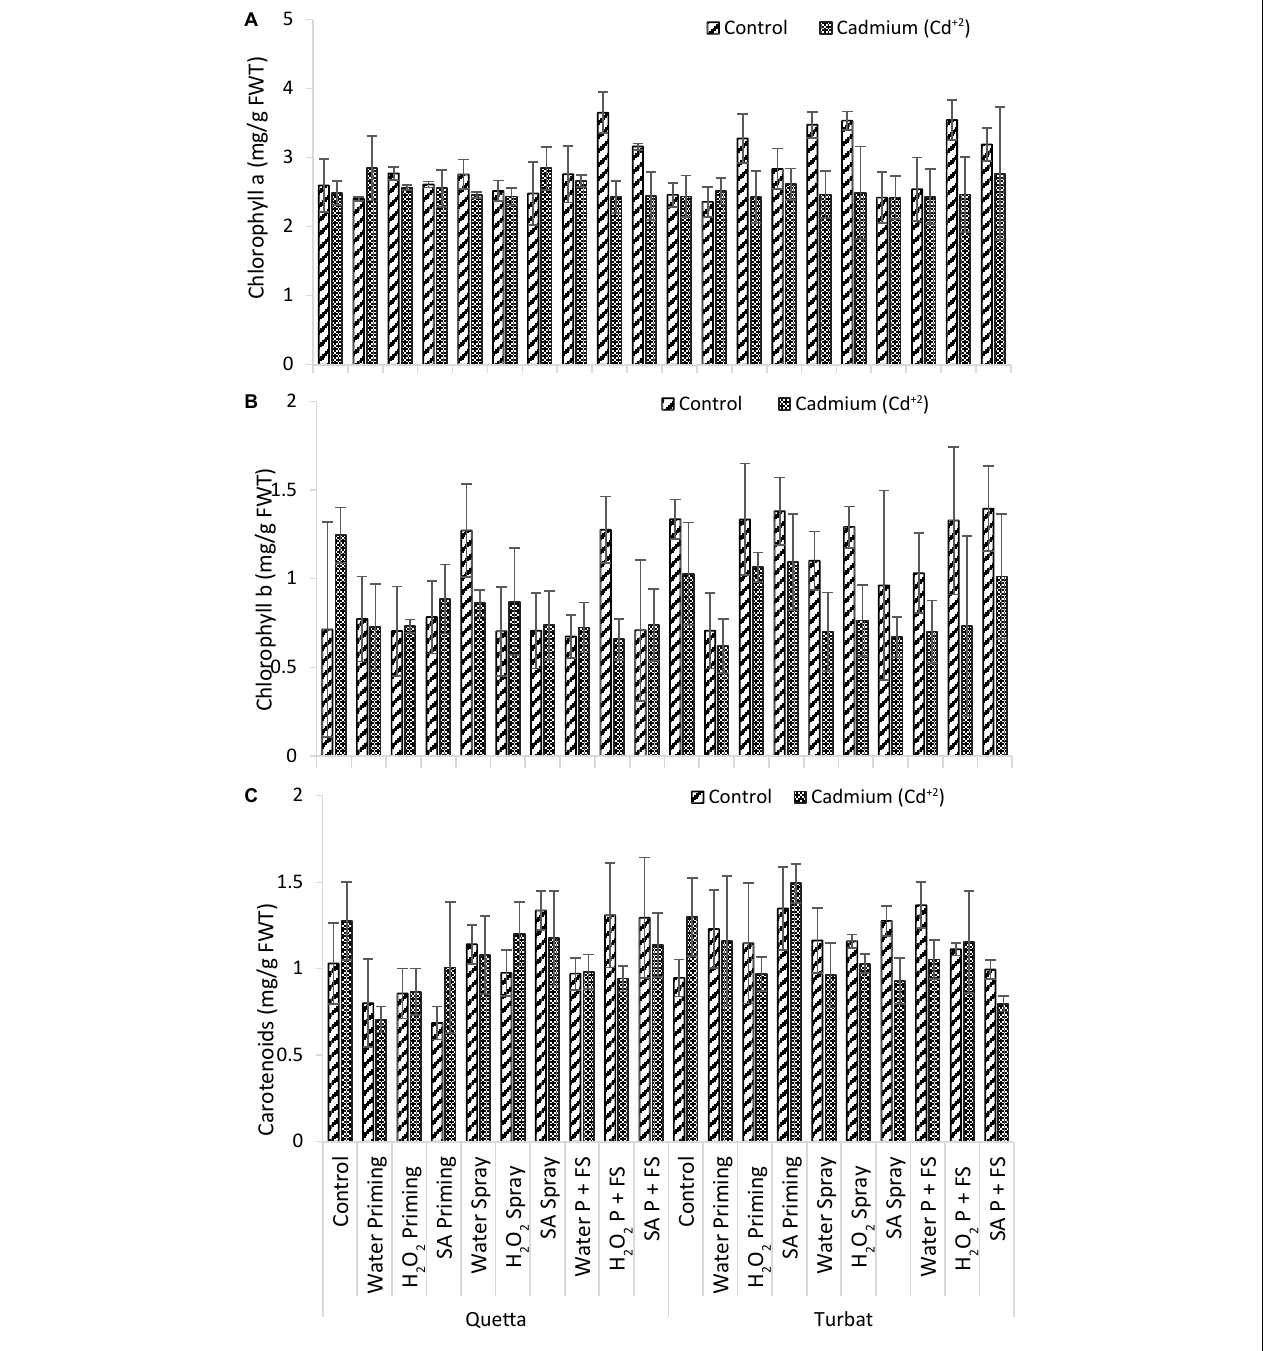
FIGURE 4 | Photosynthetic pigments; Chlorophyll a (A) , Chlorophyll b (B) , carotenoids (C) of milk thistle as affected by SA and H 2 O 2 treatment grown at Quetta and Turbat under cadmium